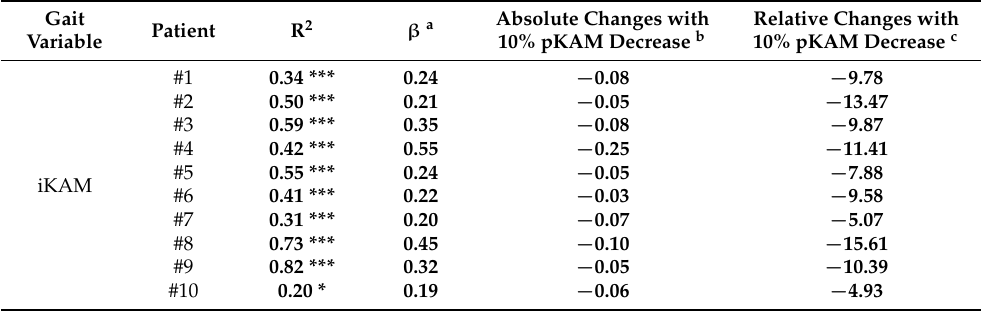
Figure 1. Effect sizes (Cohen’s d) of the intra-patient changes in gait variables between insole conditions. This figure presents the effect sizes distribution using 4-bin histograms, classifying effect sizes (ES) as very small (|ES| < 0.2), small (0.2 ≥ |ES| < 0.5), medium (0.5 ≥ |ES| < 0.8), or large (|ES| ≥ 0.8) [31]. The numbers on top of the bars indicate the average (standard deviation) magnitude of the changes included in the bin. The magnitude of changes is reported in the unit of the gait variables (%BW*Ht, %BW*Ht*s or ◦ ). Table 2. Intra-patient relationships between changes in pKAM and changes in other gait variables when walking with different